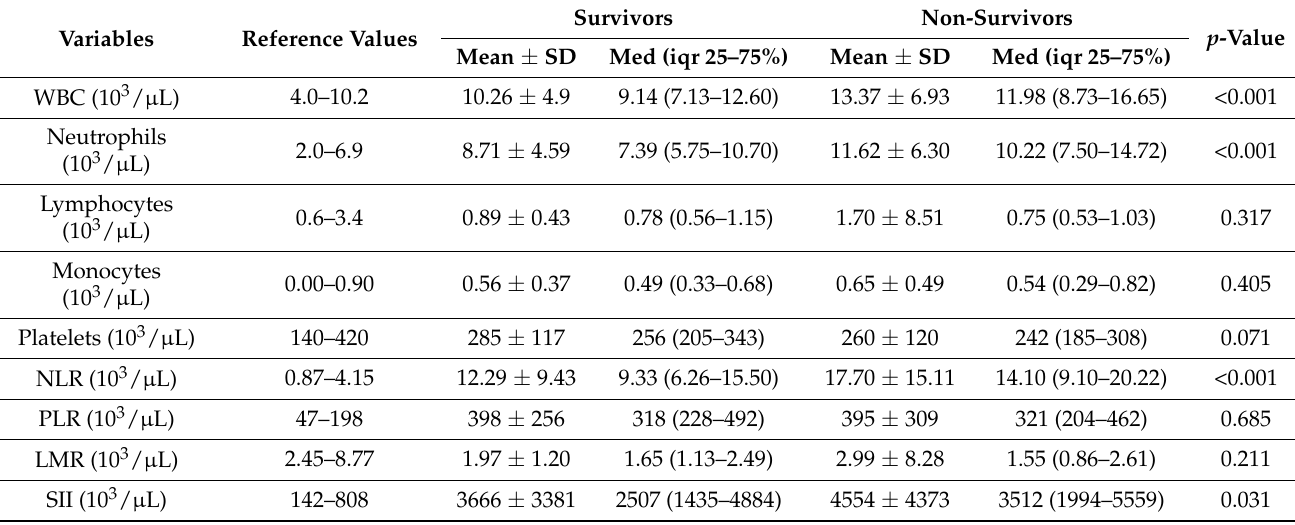
Table 3. White blood cell and platelet counts.